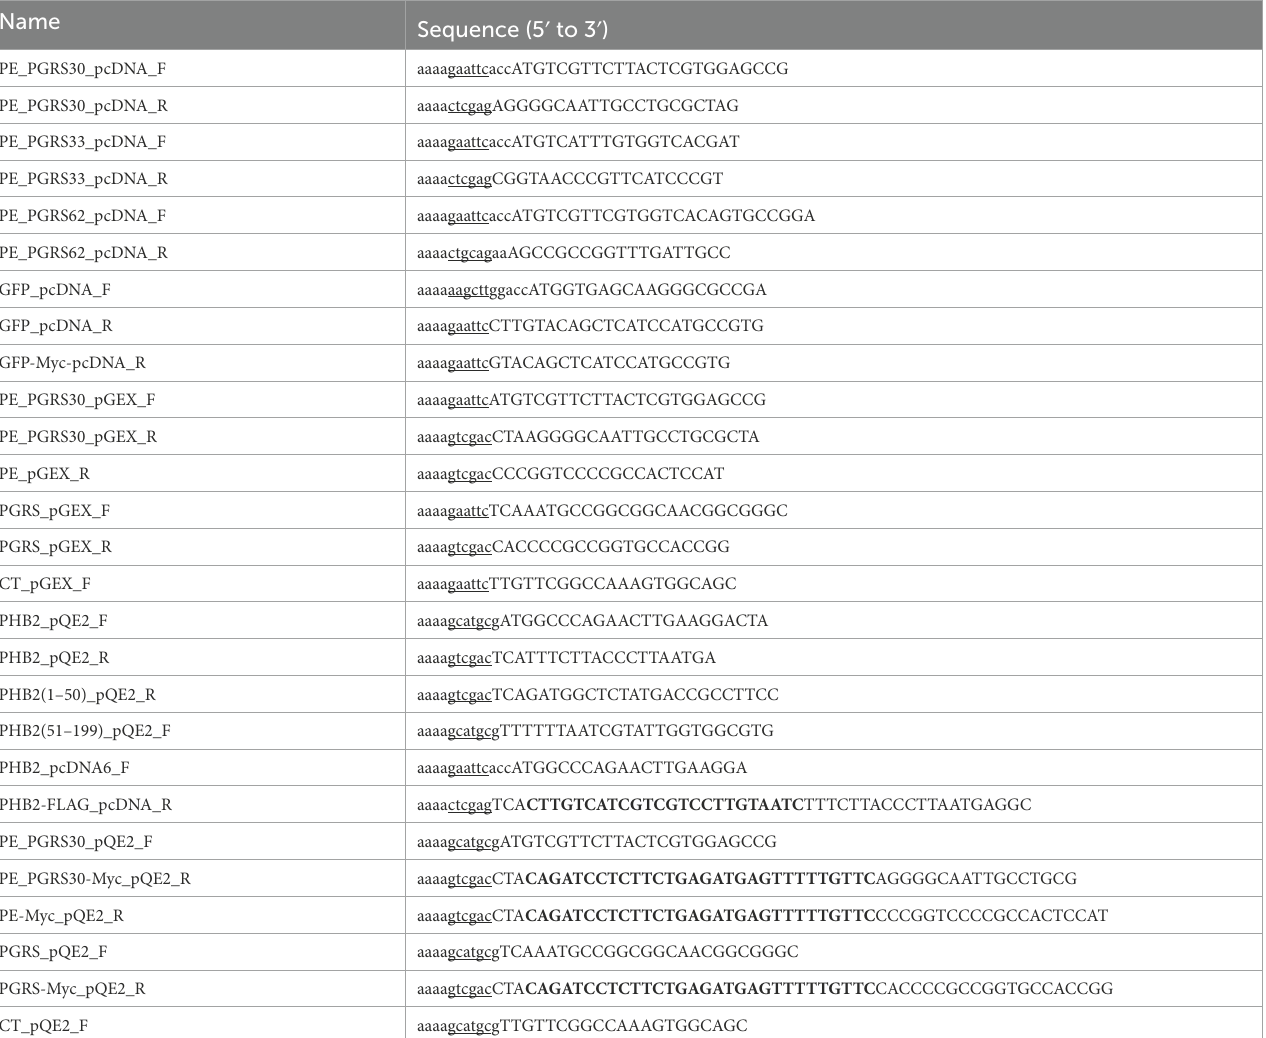
TABLE 1 Primers used in this